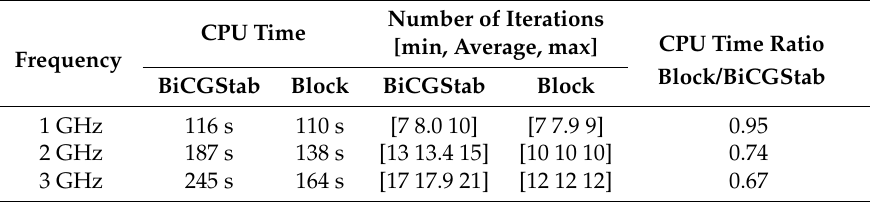
Table 1. CPU time and number of iterations required for computing the 160 forward simulations with BiCGStab and block-BiCGStab for three different frequencies. Results are averaged over the 160 resolutions for BiCGStab and over 20 realizations of the random initialization for